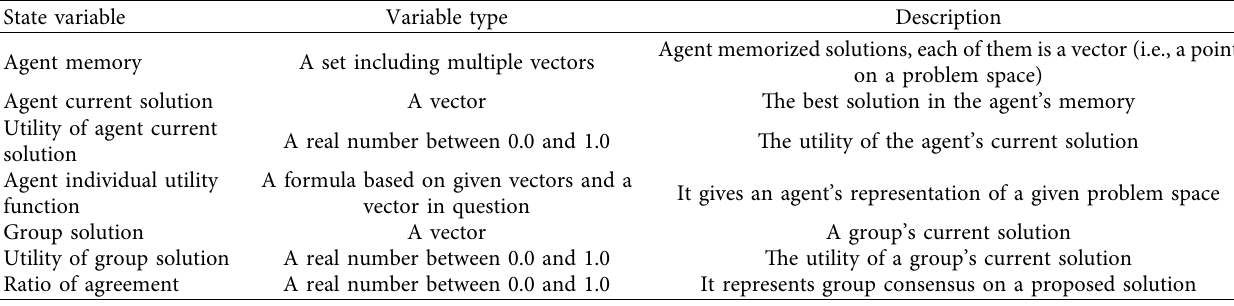
Table 2: Summary of state variables in our